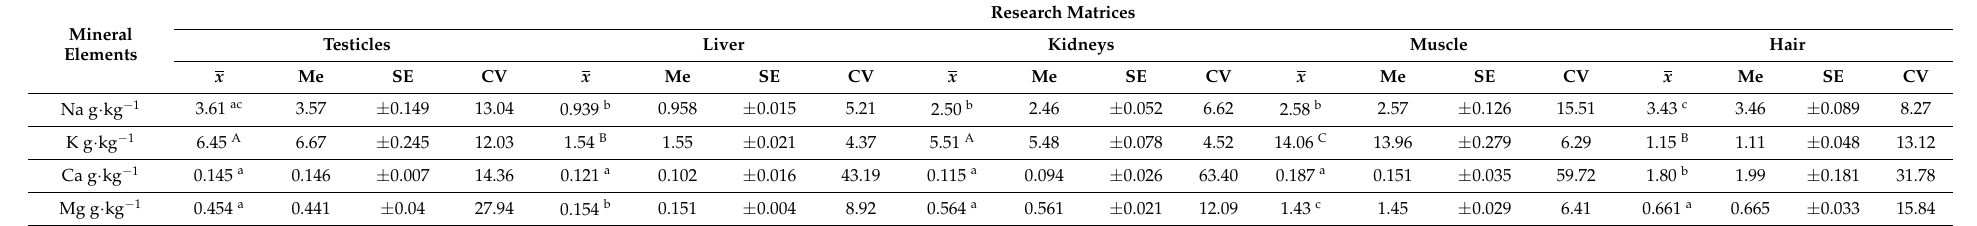
Table 2. The variability factor and content of selected macroelements in tissues and organs of red deer (g · kg − 1 of d.w.).